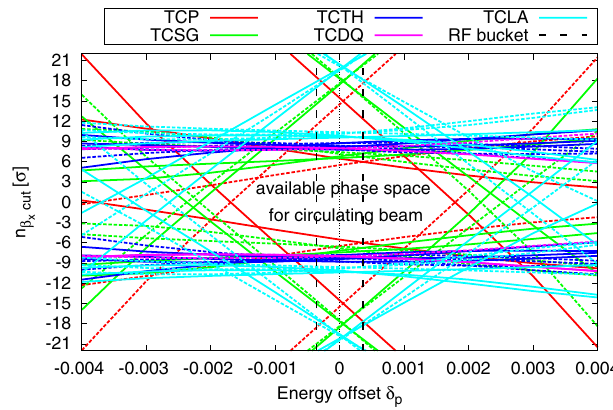
FIG. 27. (Color) CC disturbed phase space for the circulating beam by applying formula (24) ( z ¼ 1 (cid:3) z ), with the hierarchy of primary (TCP), secondary (TCSG), tertiary (TCTH), beam dump (TCDQ) horizontal collimators, and shower absorbers (TCLA) maintained. The white region labeled in the middle is the phase space available to the circulating beam.